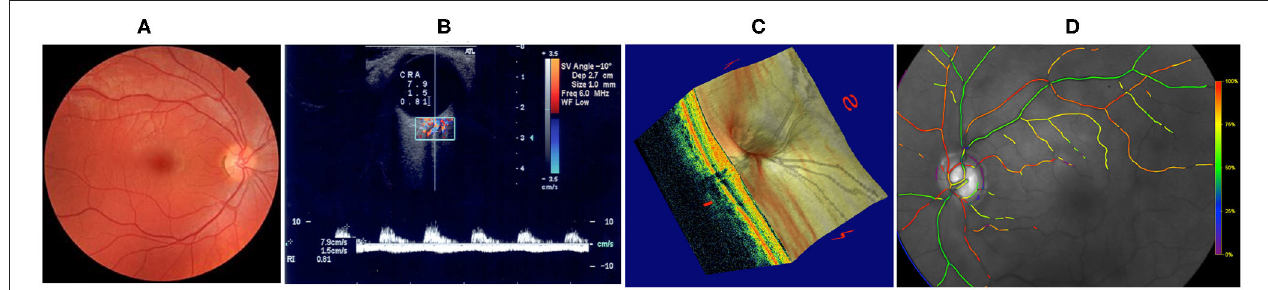
FIGURE 1 | Techniques for non-invasive ocular measurements (Guidoboni et al., 2013). (A) Fundus camera; (B) Color Doppler Imaging; (C) Fourier-Domain Optical Coherence Tomography (FD-OCT); (D) Retinal Oximetry. Images reproduced from Guidoboni et al. (2013), with